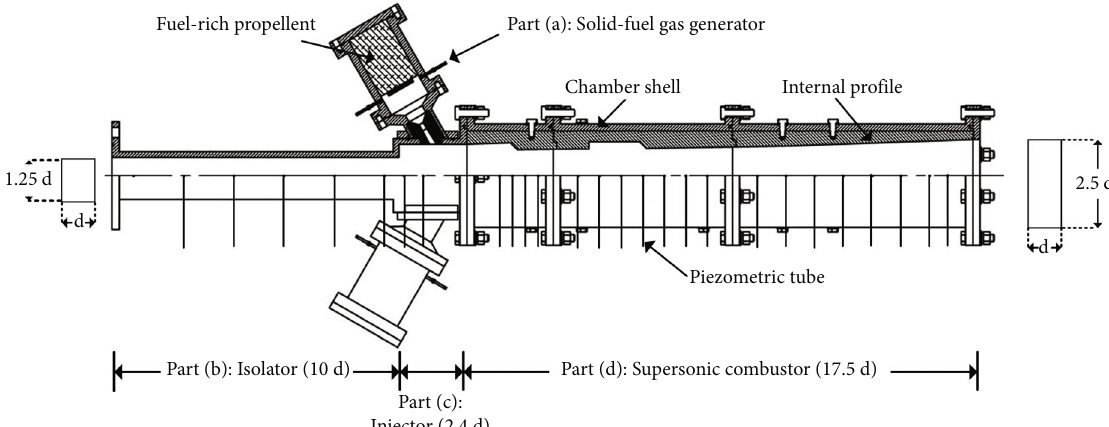
Figure 3: Schematic of the solid scramjet combustor.